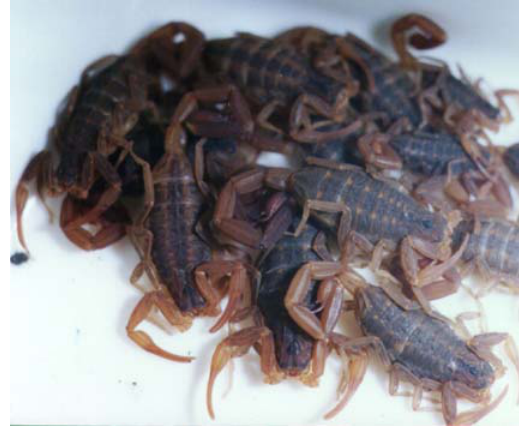
Figure 3. Tityus uruguayensis in a gregarious position.